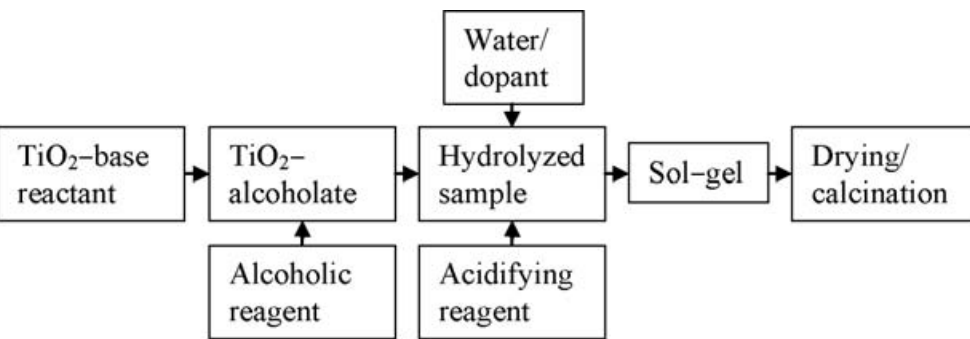
Figure 3. Schematic diagram showing the process flow chart for the preparation of TiO 2 -based film by sol-gel method. Adapted with permission from [5]; Copyright 2010 Elsevier B.V.